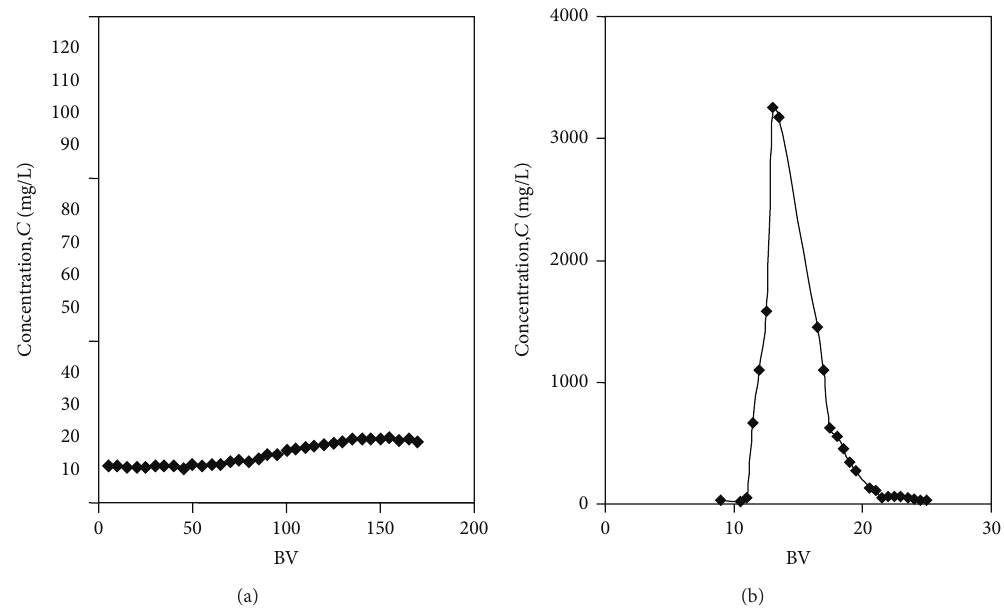
Figure 5: (a) The exhaustion breakthrough curve (first cycle). Initial chromium(III) concentration: 117mg/L; pH: 2.98 (installation II). (b) The regeneration curve (first cycle). Regenerant solution: 0.3M H 2 O 2 ; 0.2 M NaOH (installation